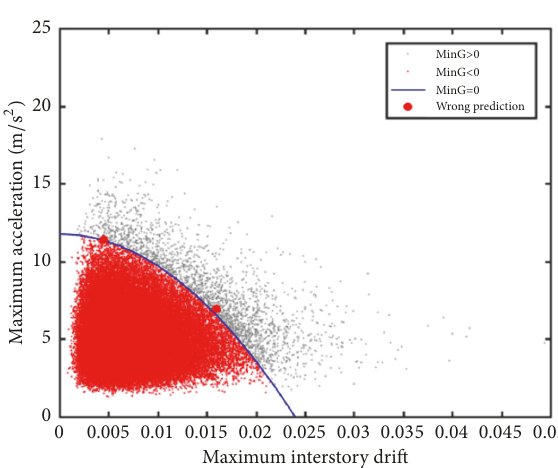
Figure 6: Sign of the minimum performance function with N 2 =2 predicted by